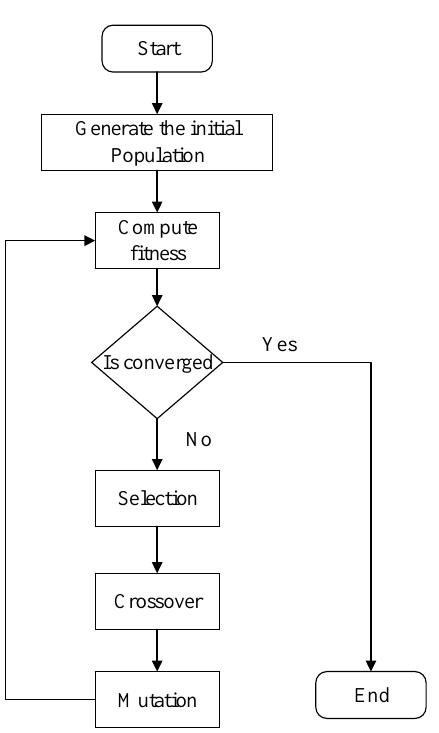
Figure 2. Basic workflow of the genetic algorithm.